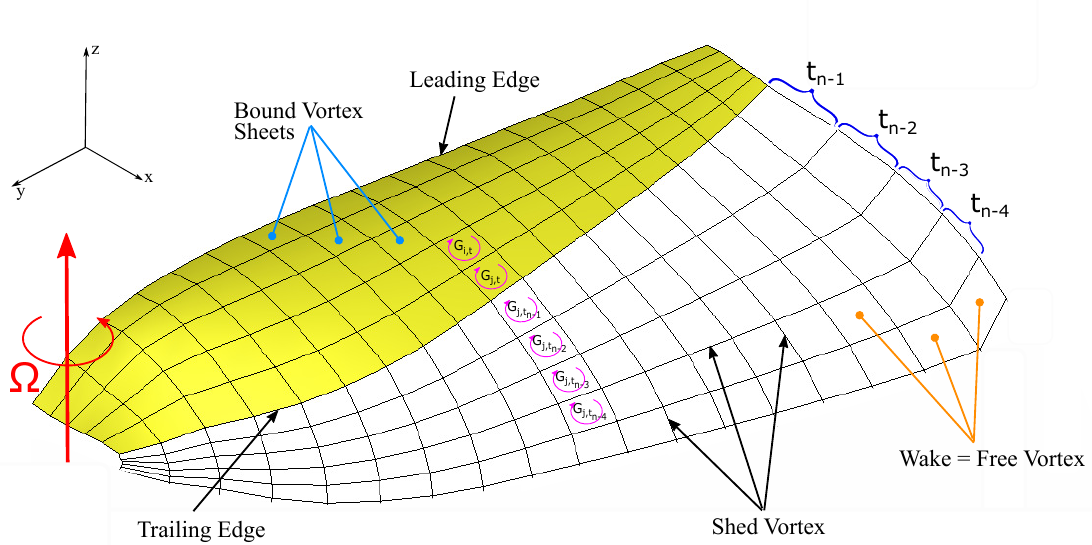
Figure 7. Descriptive diagram of the Unsteady Vortex-Lattice Method